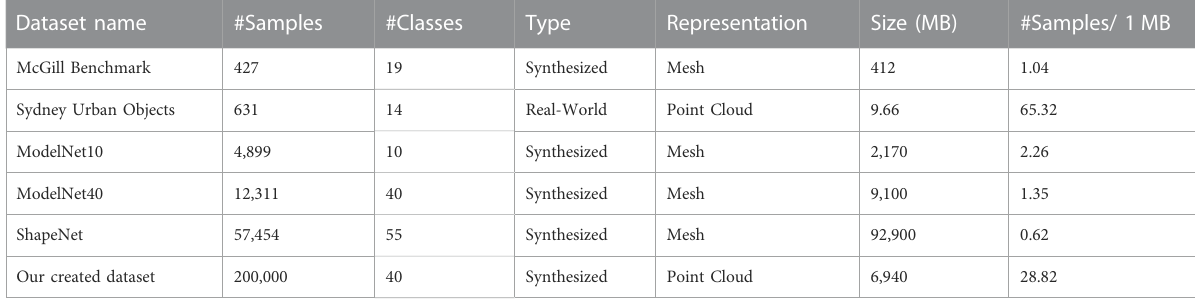
TABLE 2 Comparison between our dataset and other datasets for 3D object classi fi